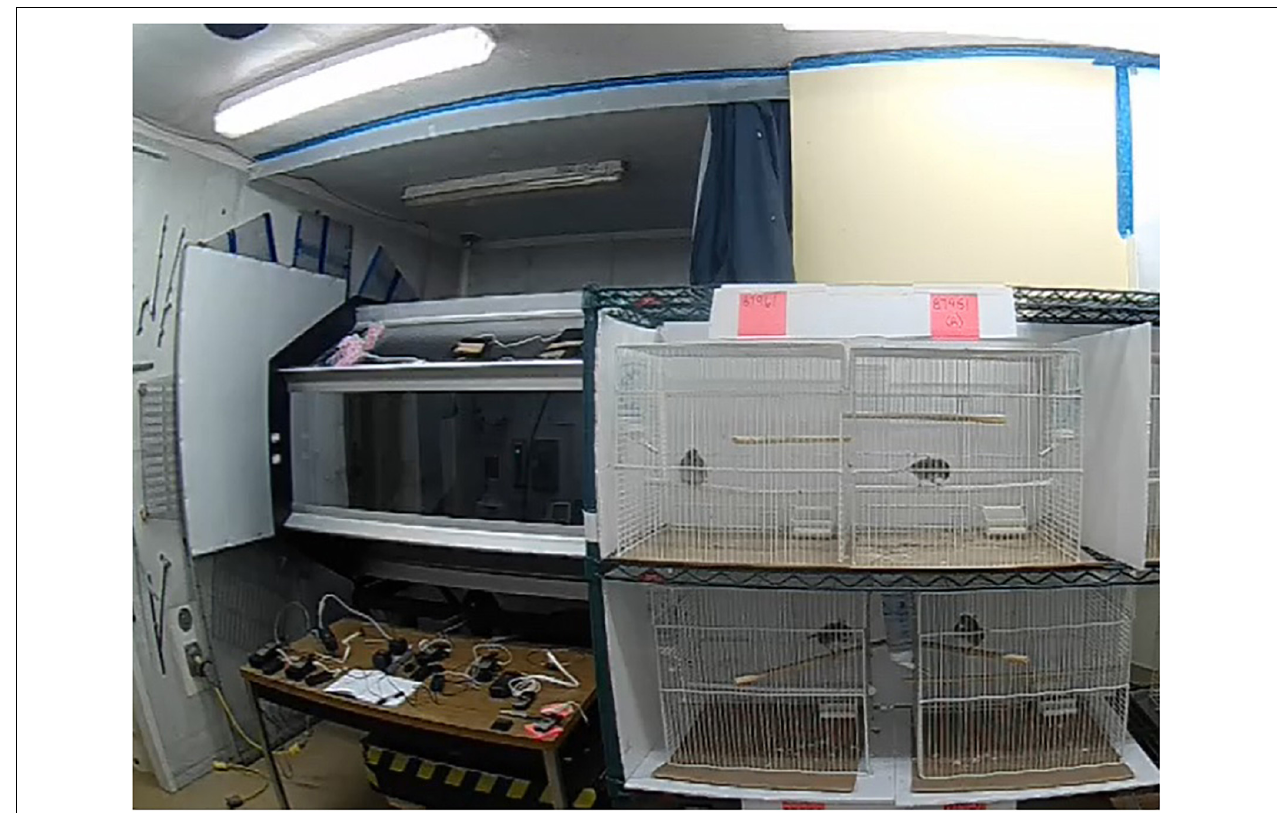
FIGURE 1 | Experimental caging in the wind tunnel plenum. Sparrows were held individually in cages on racks adjacent to the working (flight) section of the wind tunnel that can be observed to the left. A baffle (white panel) ensured air mixing between the plenum and working section so that temperature, humidity, and pressure in the plenum was identical to the air flow in the tunnel.